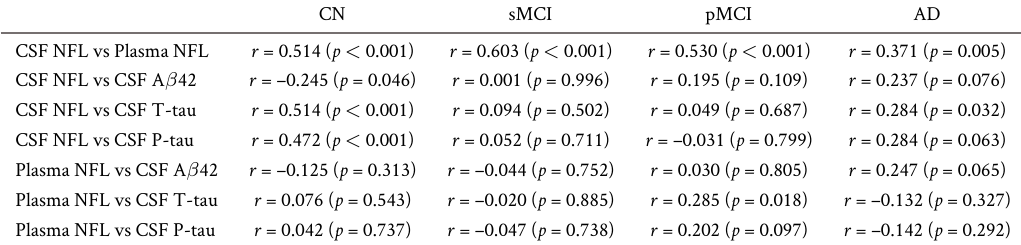
Table 2. Correlations between NFL and other biomarkers.